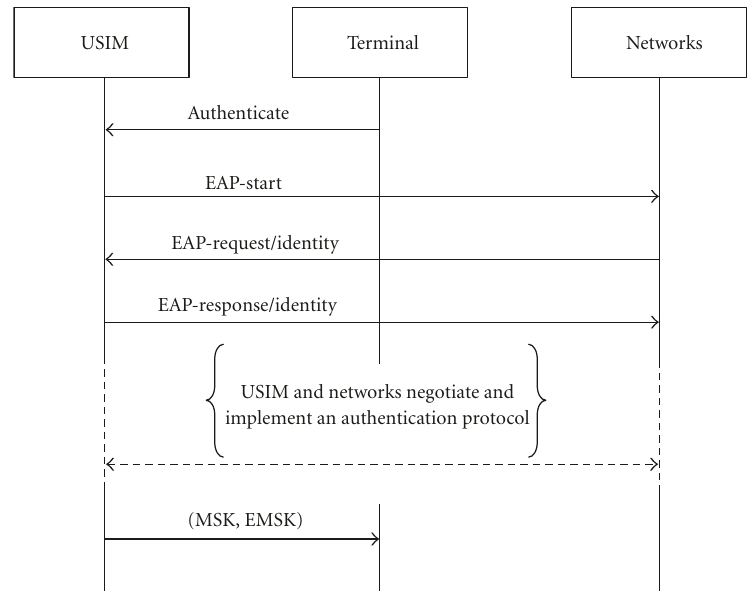
Figure 9: Message interaction procedure in uniform access